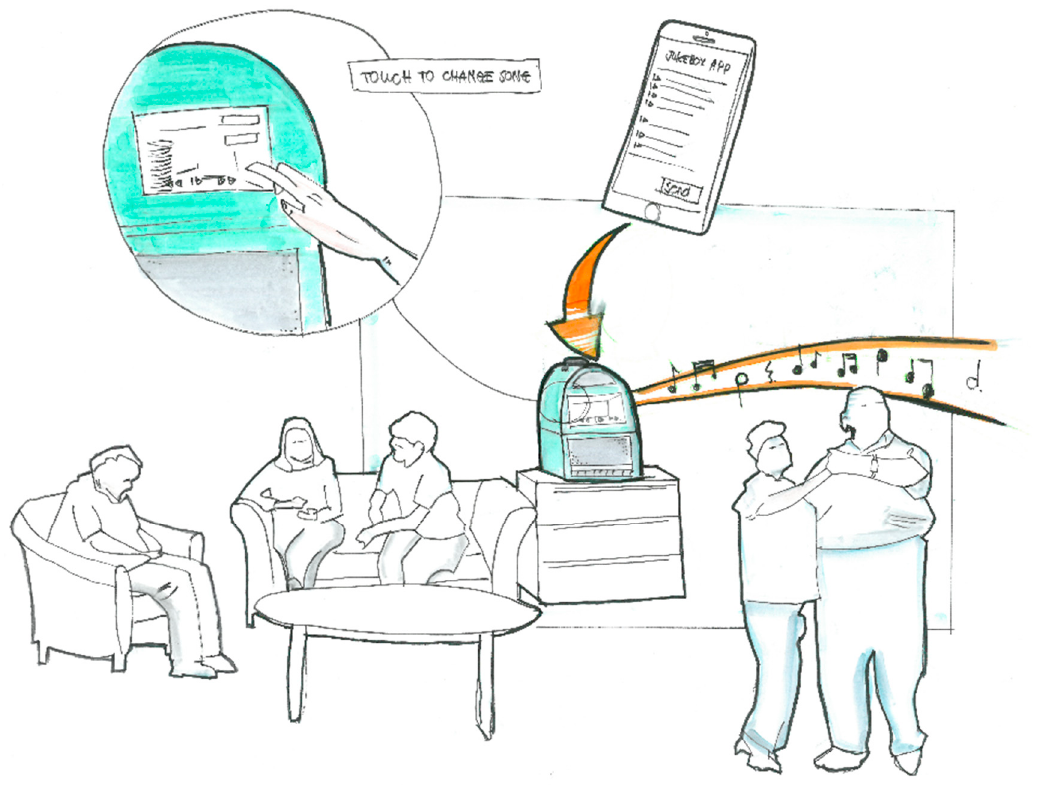
Figure 3. Functionality of the “Jukebox”.